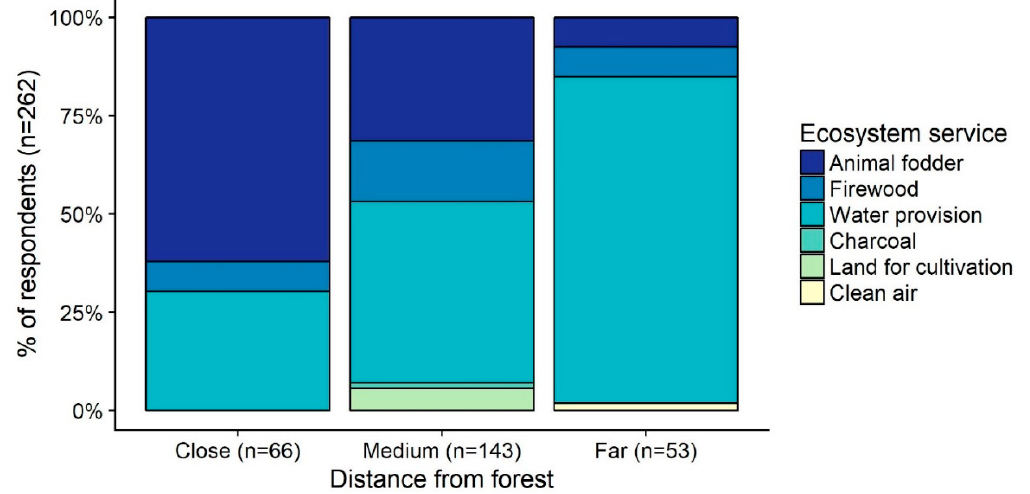
Figure 3. Perception of most important ES by respondents living in different distance from the forest “close” indicates a distance of less than 1 km to 2 km from the forest edge; “mid” means between 2 and 5 km, and households in the “far” category live between 5 km and more than 10 km from the forest.